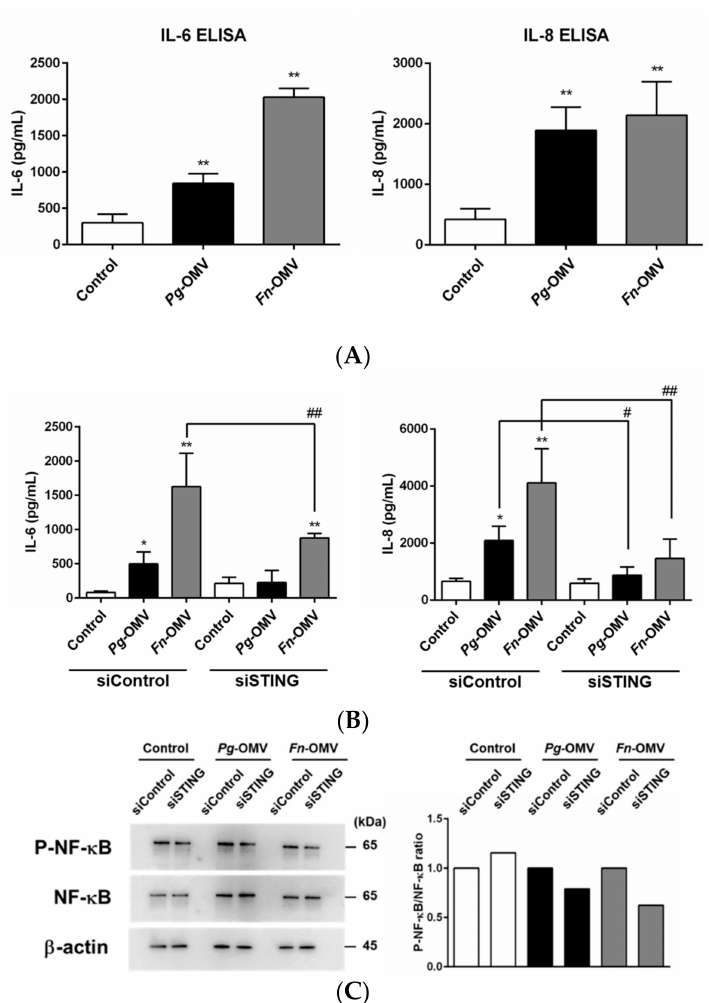
Figure 6. Comparison of Pg -OMVs and Fn -OMVs in IL-6 and IL-8 production by STING knockdown. ( A ) OBA9-cells were cultured with Pg -OMVs or Fn -OMVs for 6 h. The amount of OMVs added to cells was determined by using the same level of endotoxin activity as 100 ng/mL of Pg -LPS. IL-6 and IL-8 concentrations in the cell culture supernatants were determined using an ELISA program. ( B , C ) OBA-9 cells were transfected with STING siRNA for 24 h and cultured Pg -OMVs or Fn -OMVs for 6 h ( B ) and 30 min ( C ). ( B ) IL-6 and IL-8 concentrations in the cell supernatants were determined using an ELISA program. Data are the mean ± SD of three independent experiments. * p < 0.05 and ** p < 0.01, compared to the unstimulated control. # p < 0.05 and ## p < 0.01, compared to the negative control siRNA. ( C ) NF- κ B p65 protein levels were determined by Western blotting; representative blots are shown. The ratio of p-NF- κ B and NF- κ B is shown after correction with β -actin by densitometric analysis. That same ratio for Si control was set to